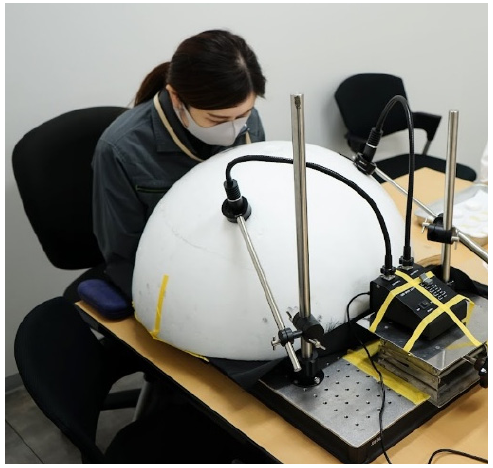
Figure 5. Photograph of the experimental set up and a panelist engaged in the sensory test.